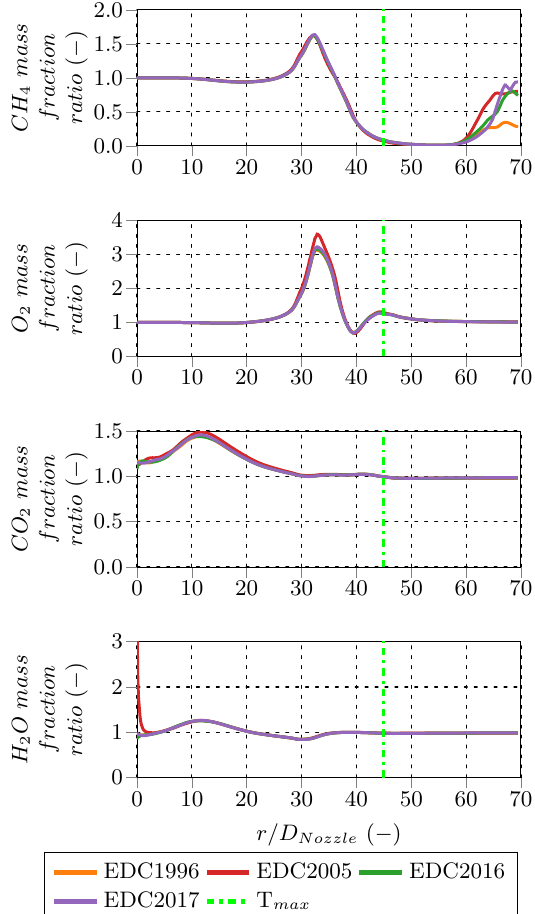
Figure 10. Ratios of PFR versus PSR centerline profiles of main species (CH 4 , O 2 , CO 2 , and H 2 O) mass fractions of flame D for all EDC model variations. Not all EDC versions are visible due to overlapping